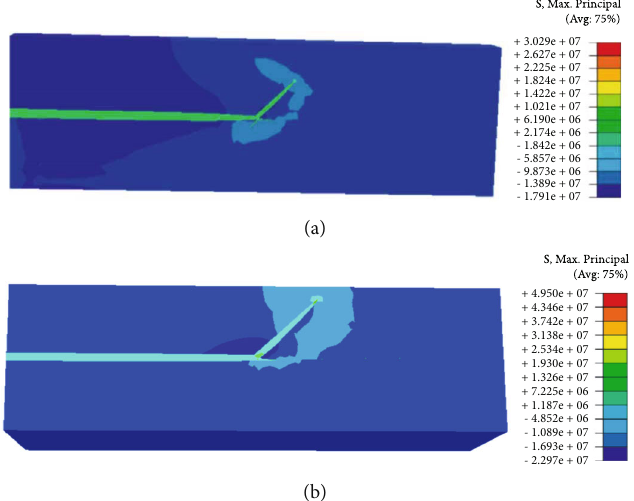
Figure 12: The comparison of contour plots of maximum principal stress between 4m and 15m formation thickness with a 45-degree approaching angle (deformation scale factor is 100): (a) 4m formation thickness and (b) 15m formation